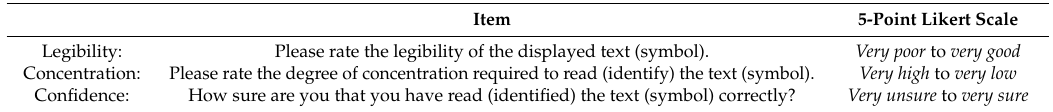
Table 2. The three items used to collect subjective